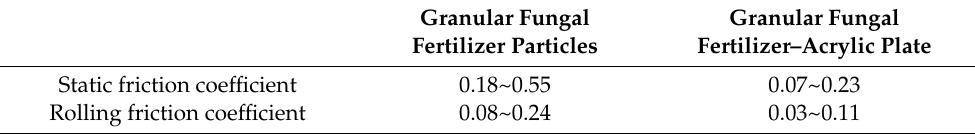
Table 4. Friction